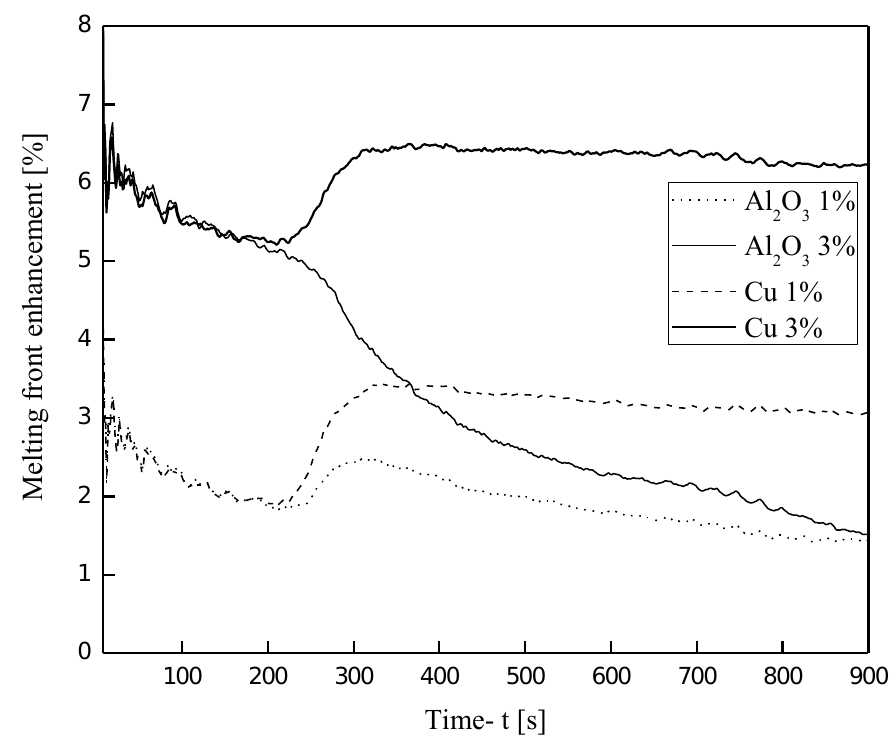
Figure 16. Melting front enhancement with the nanoparticles’ utilization.